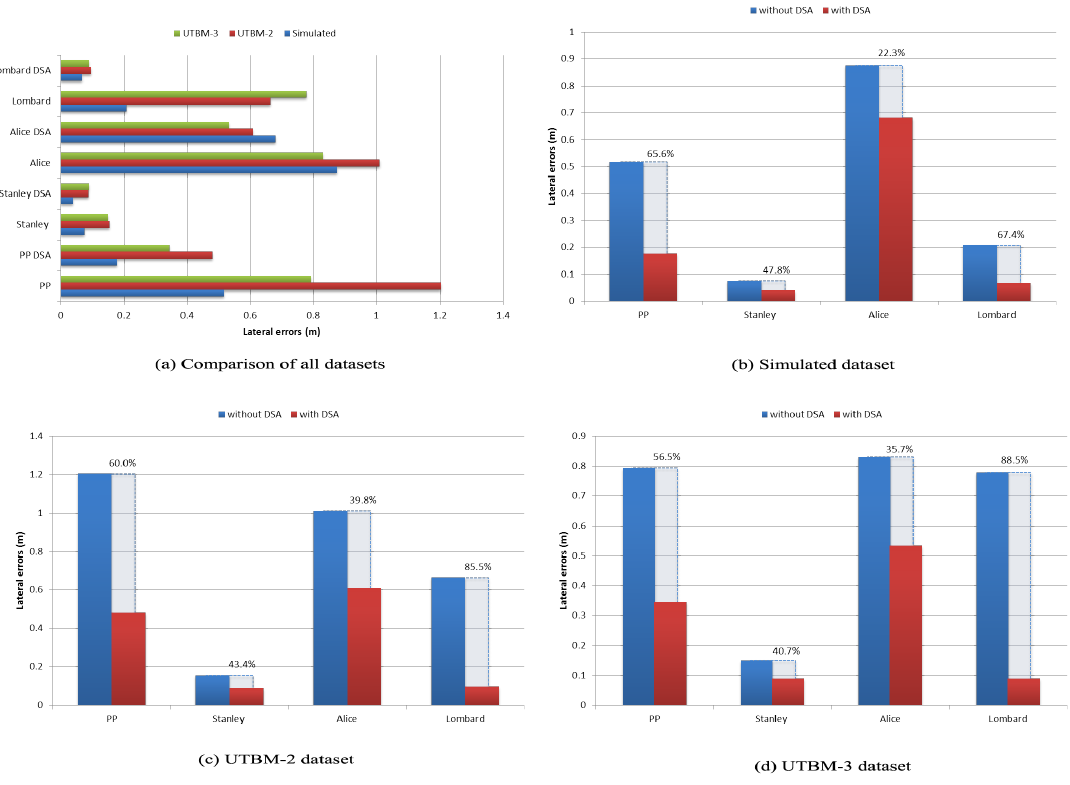
Figure 14. Root mean square error ( e rms ) comparison of lateral errors obtained in sharp curves for each